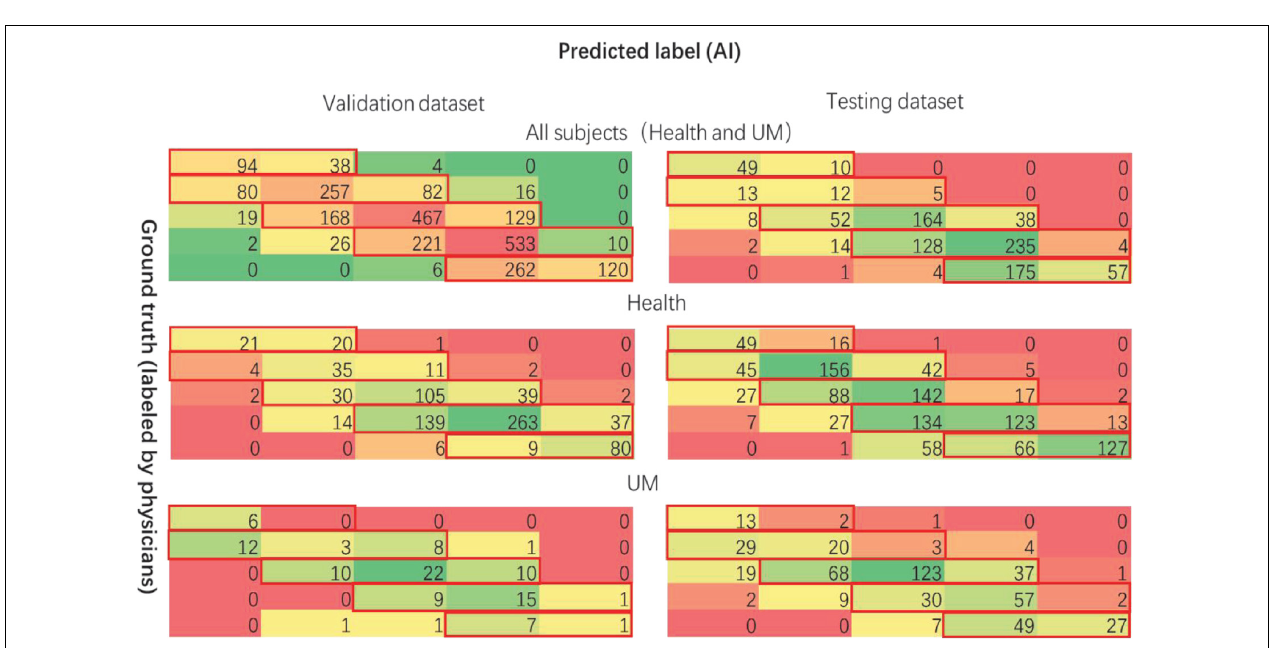
FIGURE 9 | The performance for evaluating the color of iris (RF). The left-hand side is listed as the validation dataset, and the right-hand side is listed as the testing dataset. The first line shows all subjects, the second one shows the nontumor control datasets, the third one shows the tumor patient datasets.